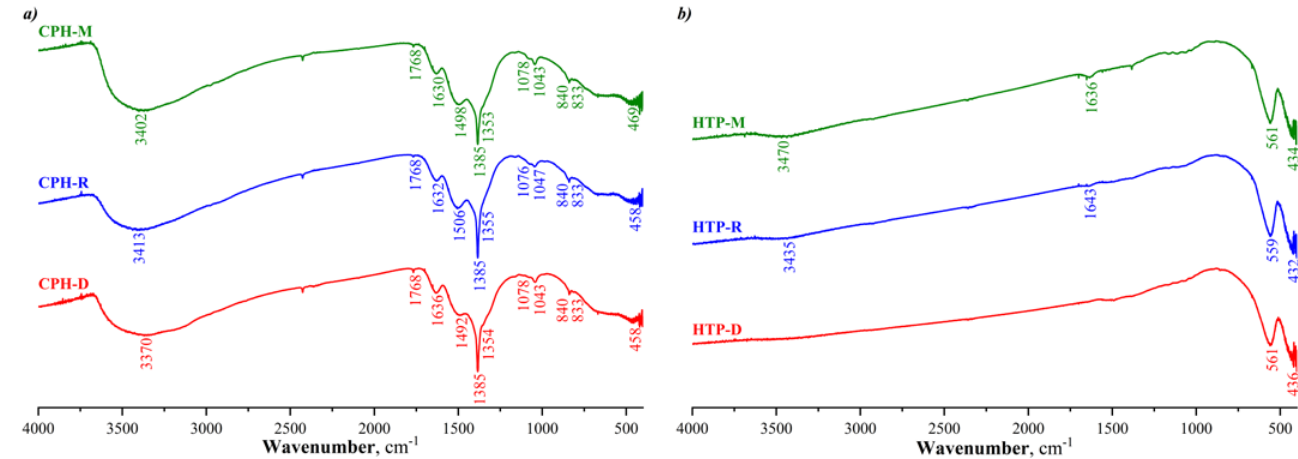
Figure 4. FTIR spectra of the samples of co-precipitated hydroxides ( a ) and their heat-treated products ( b ). Table 1. Assignment of bands in the FTIR spectra of the samples of co-precipitated hydroxides. Wavenumber (cm − 1 )